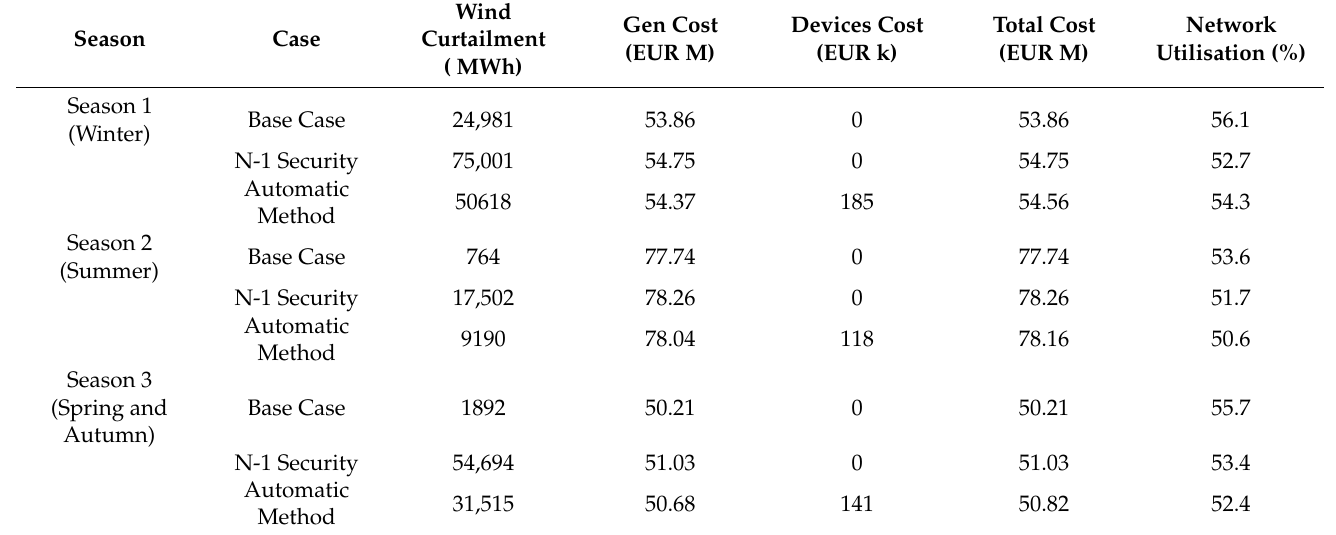
Table 5. Mobile MSSSC allocation simulation results with 1 × 150 MW